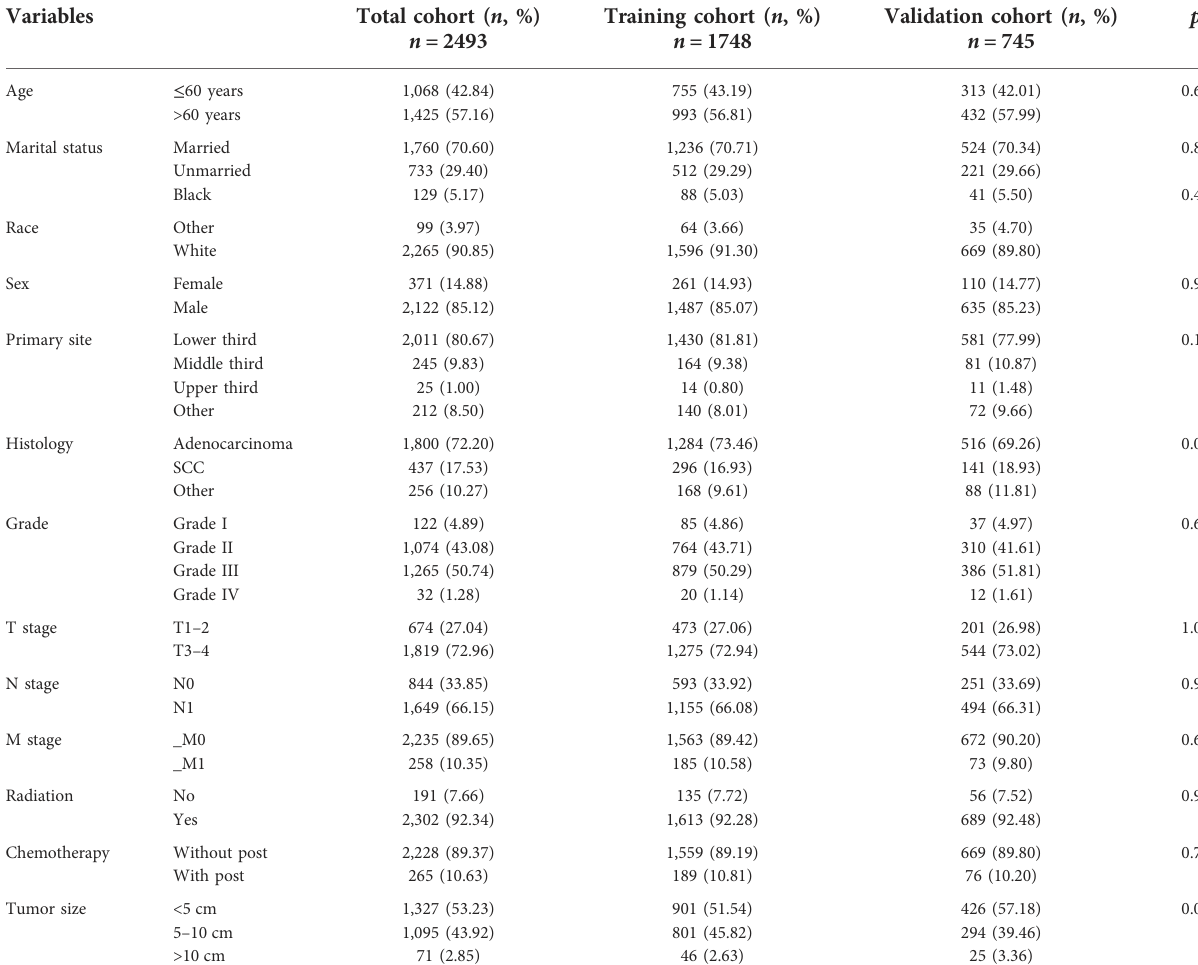
TABLE 1 The demographic and clinicopathological information of esophageal cancer patients receiving neoadjuvant chemotherapy.